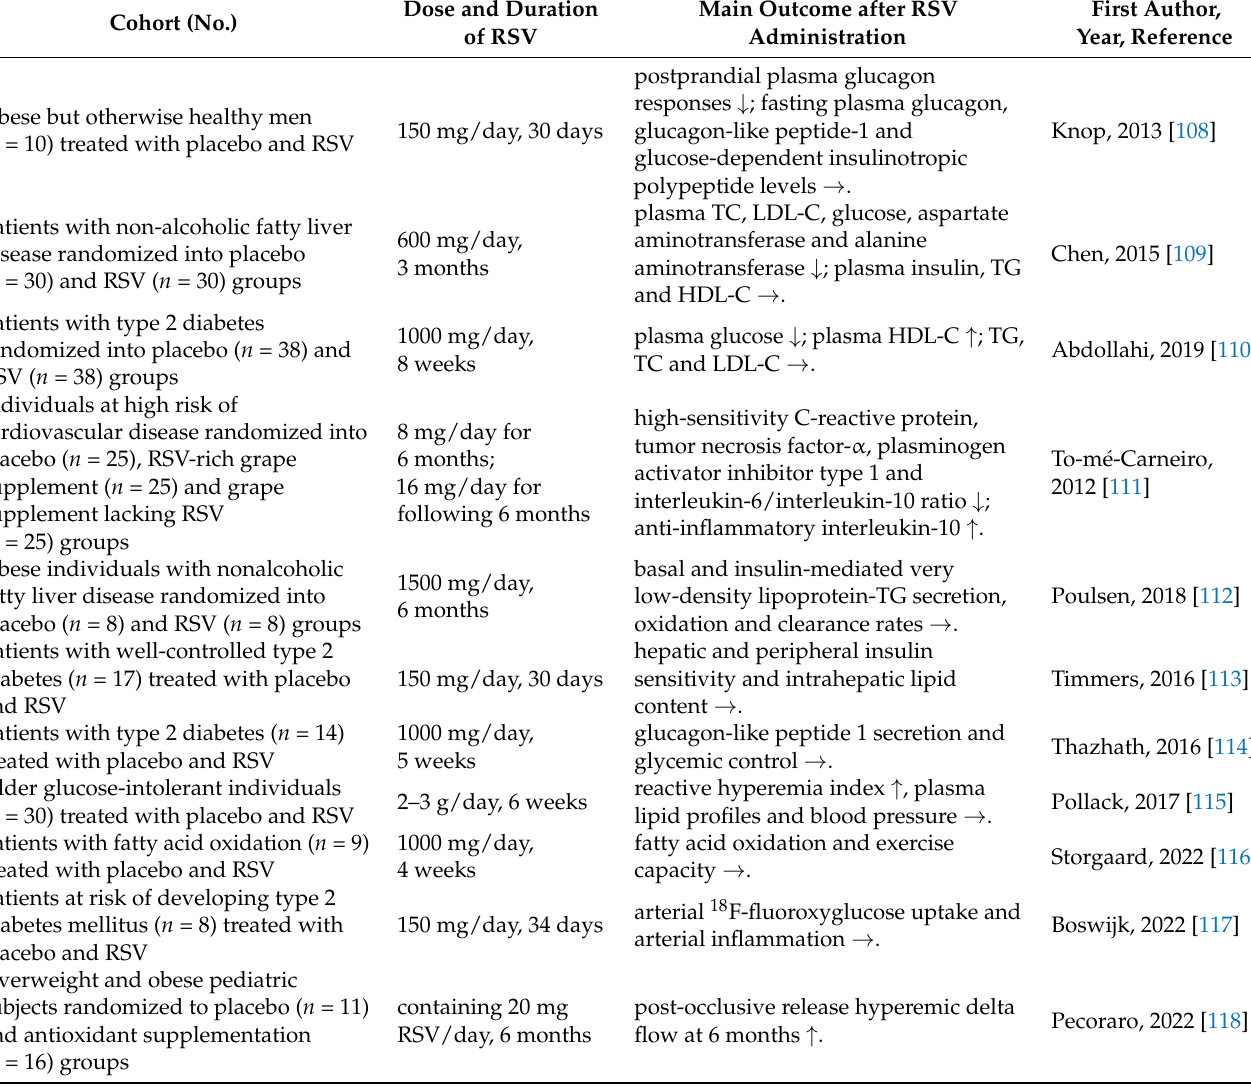
Table 4. Summary of clinical trials involving the use of RSV in vascular complications of metabolic disease. Cohort